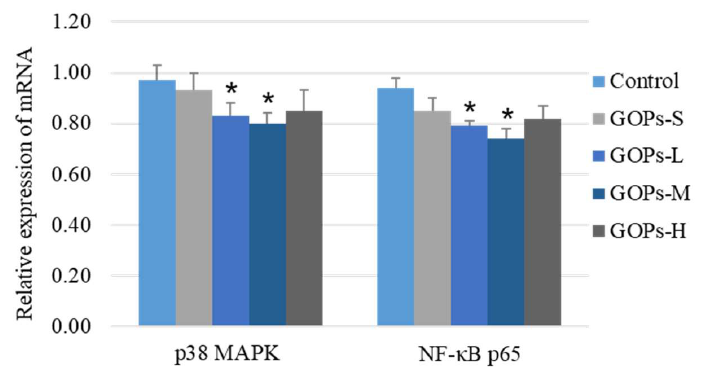
Figure 2. Effect of GOPs on the mRNA expression of p38 MAPK and NF-κB p65 in paw tissue of rats by real-time PCR analysis. β-actin mRNA levels were used as a control. Data are expressed as means ± SD and analysis via the one-way analysis of the variance test. n = 8/group. * p < 0.05 compared with the control. p38 MAPK, p38 mitogen activated protein kinase. NF-κB p65, Nuclear factor-κB p65. GOPs-S, 62.5 mg/kg*bw ginseng oligopepides treated group. GOPs-L, 125 mg/kg*bw ginseng oligopepides treated group. GOPs-M, 250 mg/kg*bw ginseng oligopepides treated group. GOPs-H, 500 mg/kg*bw ginseng oligopepides treated